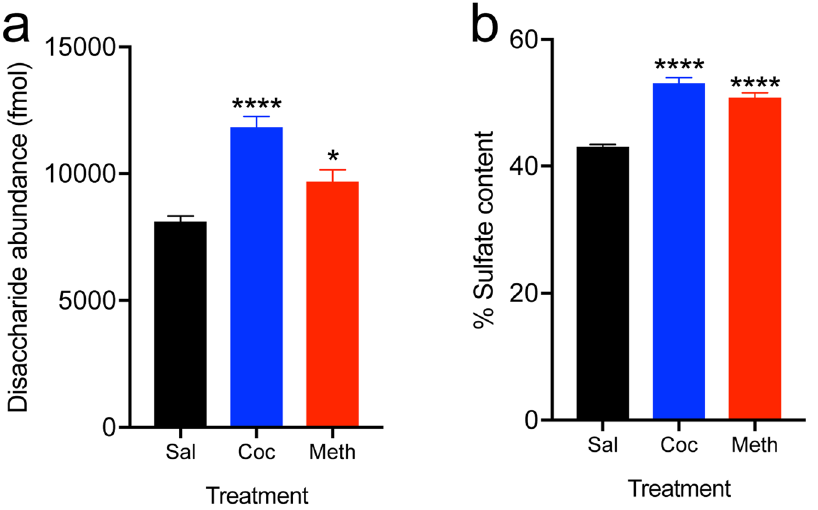
Figure 1. Stimulants increase heparan sulfate abundance and sulfation. ( a ) Cocaine and methamphetamine increase HS content. Total HS abundance was significantly increased by cocaine (Coc, n = 6) and methamphetamine (Meth, n = 5) in the LH, a brain region where the HS proteoglycan syndecan-3 was previously found to regulate cocaine intake 8 . ( b ) Cocaine and methamphetamine significantly increase HS sulfation. * P < 0.05, **** P < 0.0001, significant difference from saline (Sal) control ( n = 6; one-way ANOVA followed by Fisher’s LSD test). The data are expressed as mean + SEM.